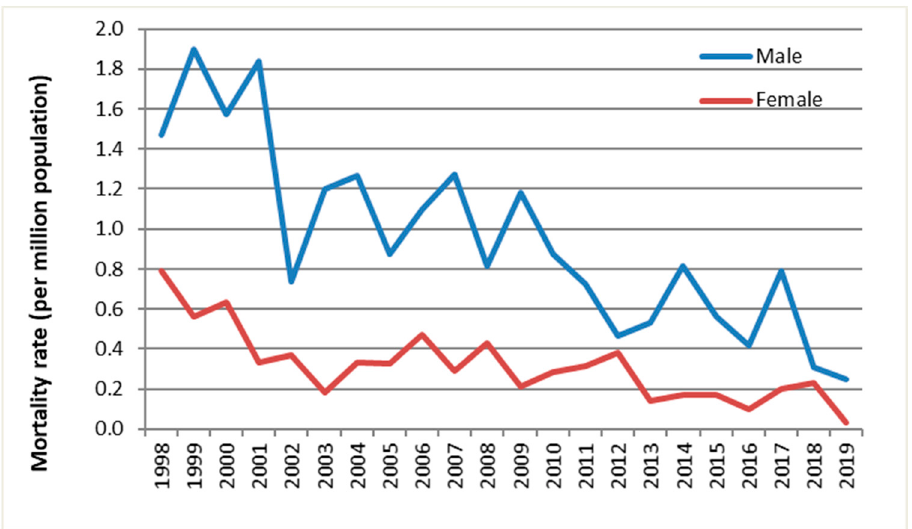
Figure 1. The annual mortality rate of fatal UNFR CO poisoning in England and Wales by sex and year, 1998–2019.